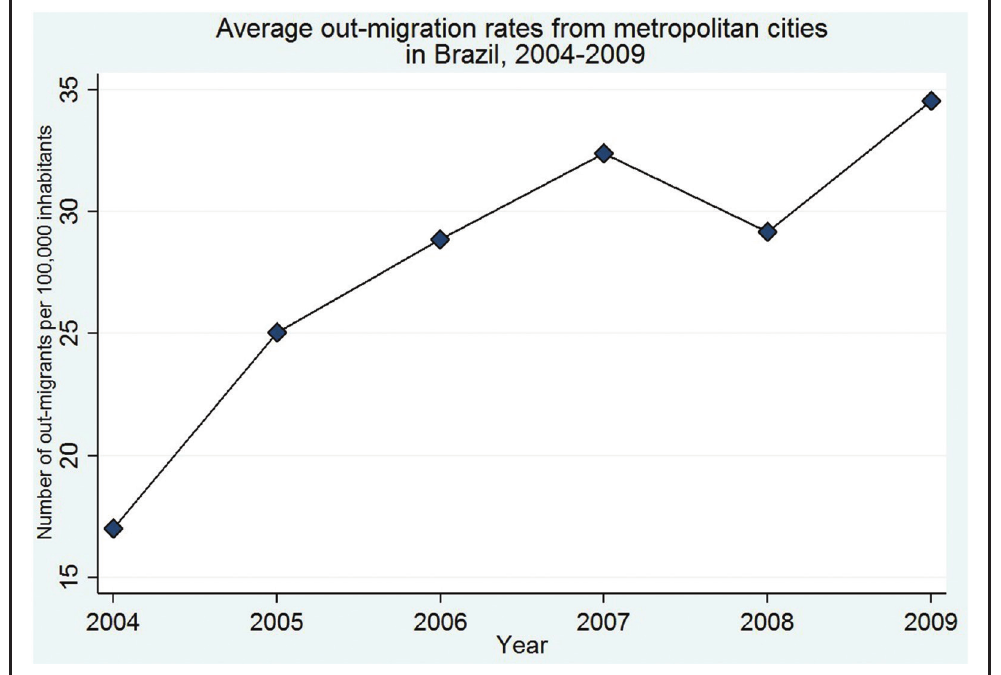
Figure 2 Out-migration rate from metropolitan cities from 2004 to 2009.